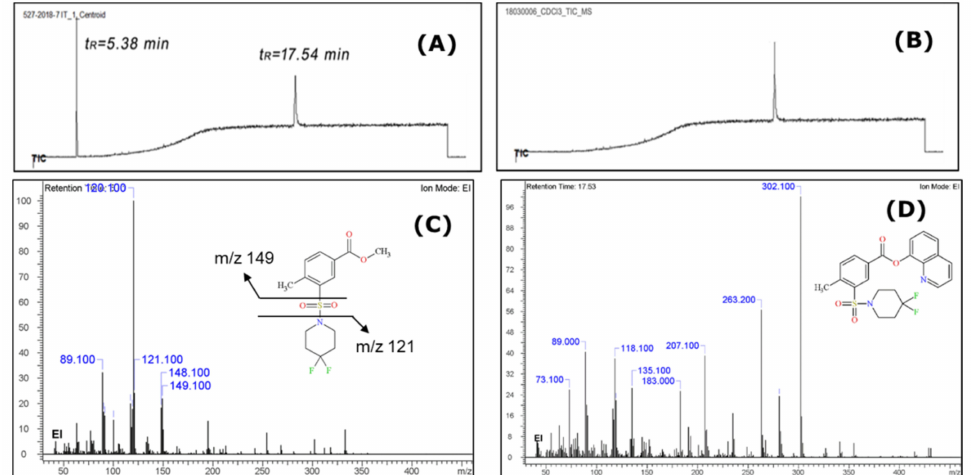
Figure 1. GC total ion chromatogram (Scan mode) of the methanol extract ( A ), chloroform extract ( B ) and EI-MS spectra of the identified methylated precursor of 2F-MPSBA in the methanol extract (t R = 5.38 min) ( C ) and the identified synthetic cannabinoid 2F-QMPSB, (t R = 17.54 min) ( D